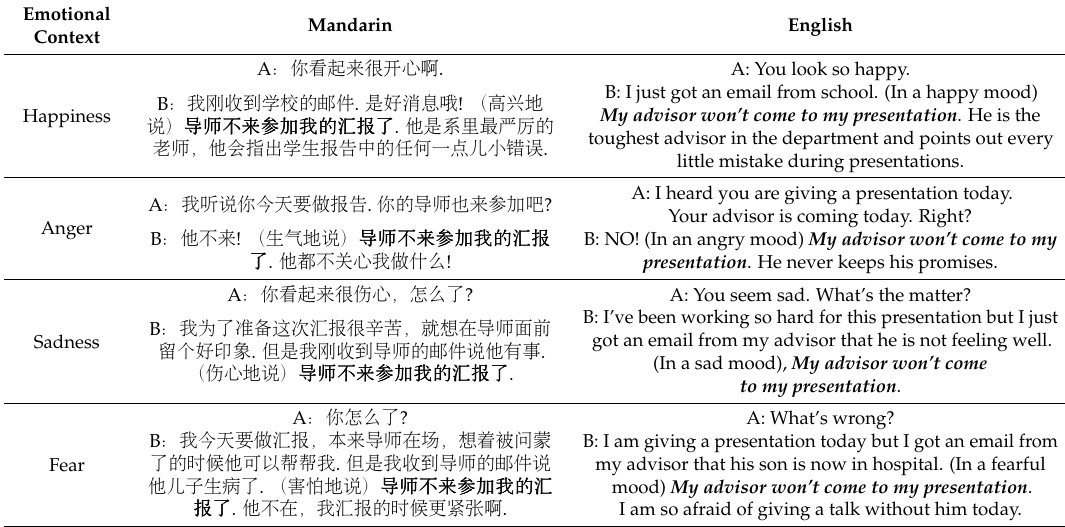
Table 1. An example of the target sentence “My advisor won’t come to my presentation” in four emotional dialogue